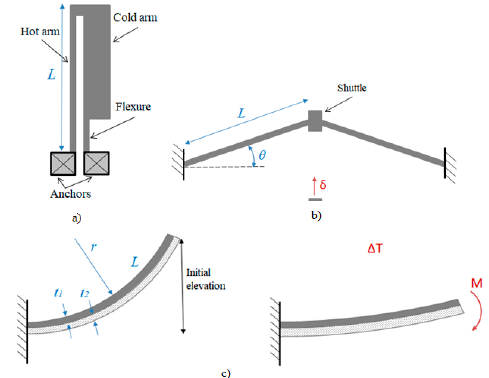
Figure 15. Schematic diagram of electrothermal actuator: ( a ) hot-and-cold arm actuator; ( b ) Chevron actuator; ( c ) bimorph actuator at initial state and under actuation (taken with the permission of [100]).